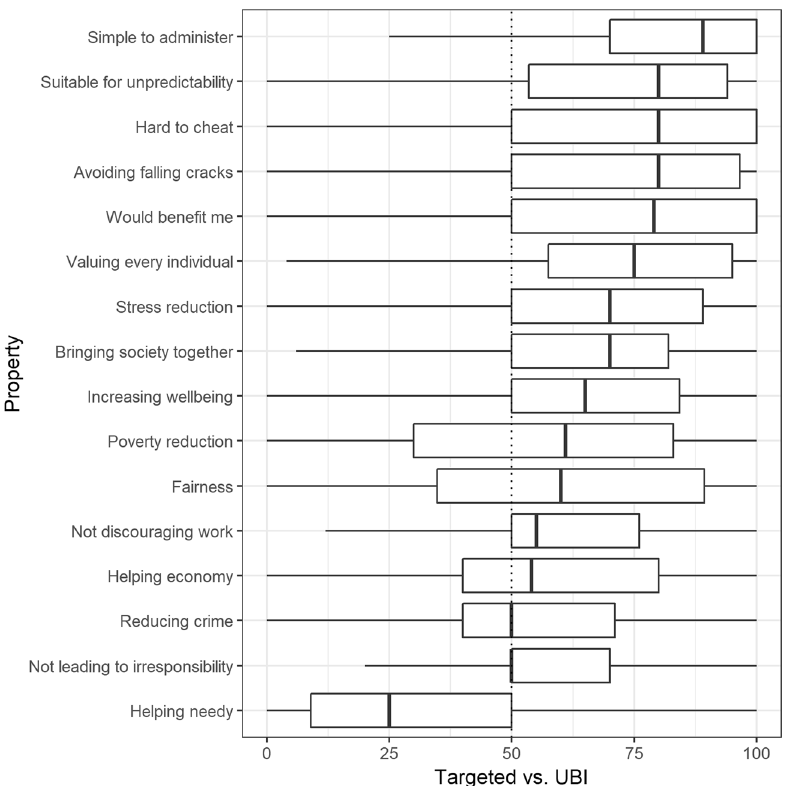
Fig. 4 Advantages and disadvantages of UBI, study 2. Boxplots of ratings of the extent to which a targeted welfare system (0) or a UBI (100) better satis fi es sixteen properties of a social transfer